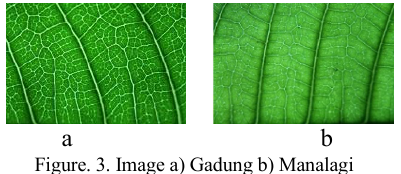
Figure. 3. Image a) Gadung b) Manalagi